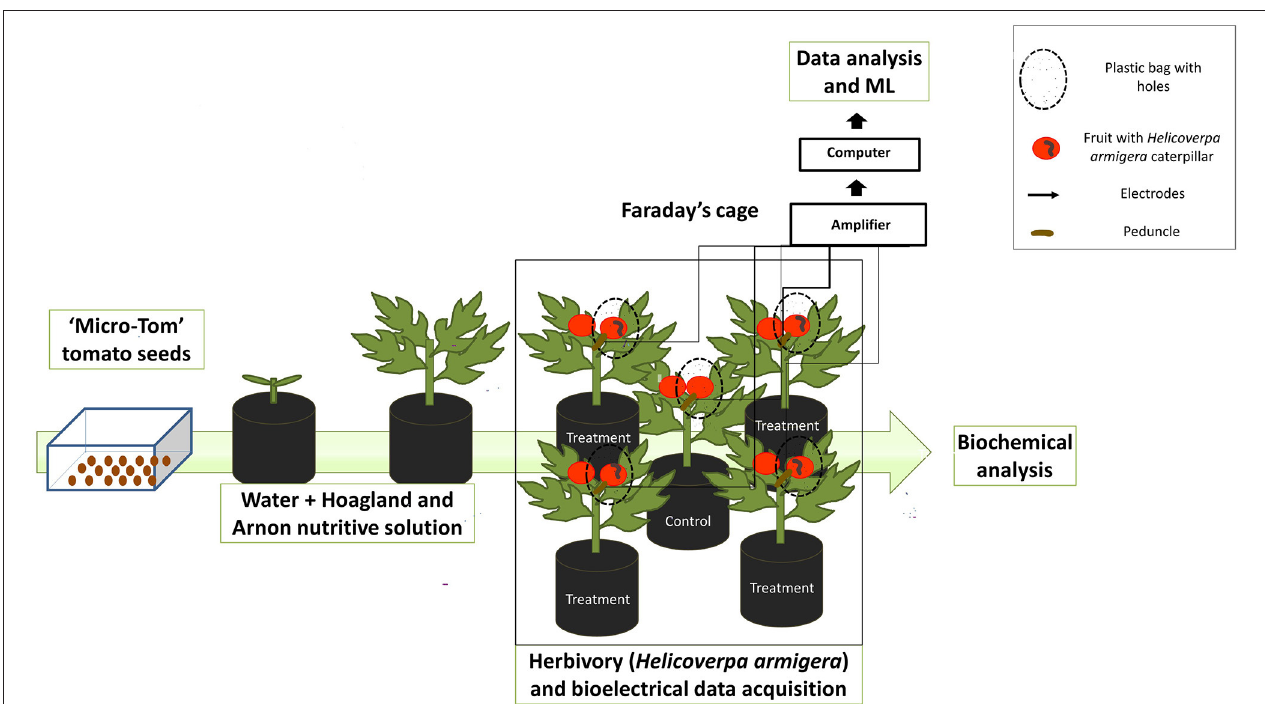
FIGURE 1 | Schematic representation of tomato plant cultivation and experimental set up. Tomato plants were grown until the reproductive stage. Plants with mature green and red fruit were used in the experiment (here we only represented the red fruit). A total of 5 plants were used by assay, 1 control and 4 plants inserted with H. armigera in the fruit. The control was used to collect the fruit and leaves for biochemical analysis and the plants under herbivory were used to the electrophysiological